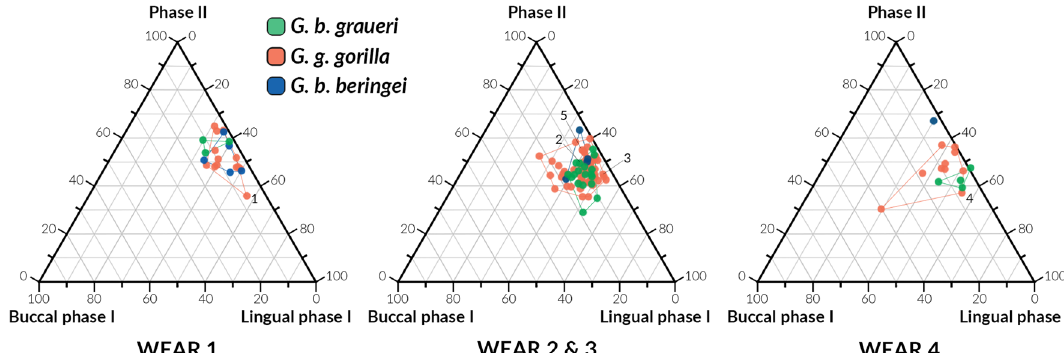
Figure 2. Ternary diagrams showing the proportions (in %) of relative wear areas of buccal phase I facets, lingual phase I facets, and phase II facets, which are positioned in an equilateral triangle. Each base of the triangle represents a ratio of 0% while the vertices correspond to a percentage of 100%. Tip crush areas were included in phase II facets. Gorilla beringei graueri in green, Gorilla gorilla gorilla in orange, and Gorilla beringei beringei in blue. Specimens 1 = AMNH 115609, 2 = AMNH 200506, 3 = SMF 59159, 4 = ZMB 47526, and 5 = BM 64.12.1.5.